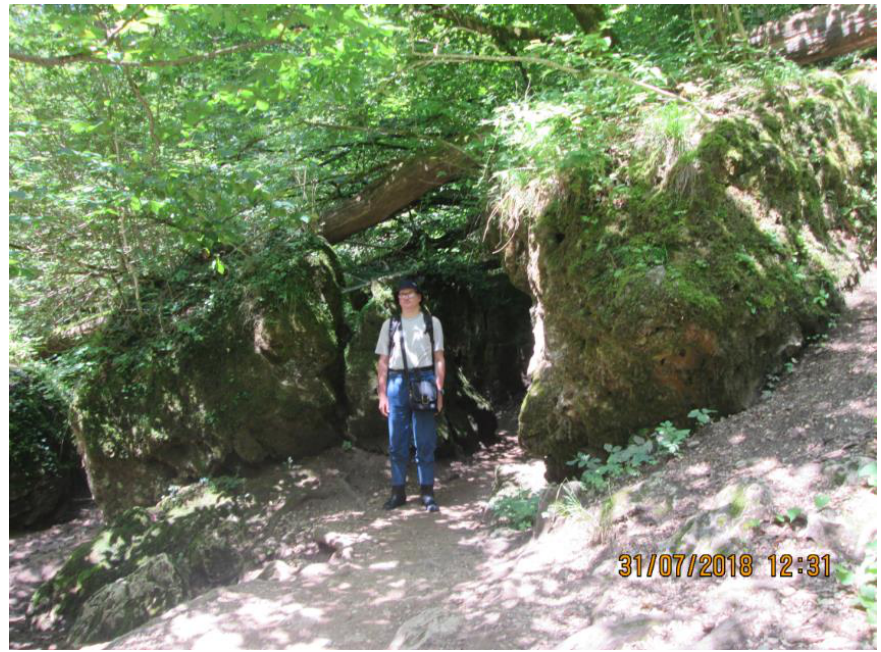
Figure 1. Upper Jurassic limestone megaclasts fallen to the bottom of the Rufabgo Canyon in the Western Caucasus; the person provides a sense of scale (used by permission of N.V. Ruban).